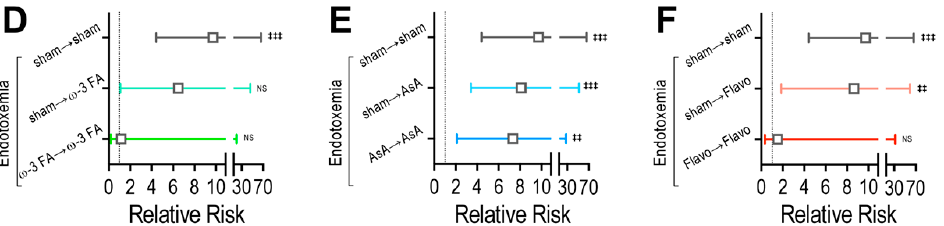
Figure 8. Survival and risk of death through dietary ω -3 FA, ascorbic acid, or polyphenolic antioxi- dant flavonoid supplementation in endotoxemic rats. Survival (Kaplan–Meier) curves comparing ω -3 FA ( A ), ascorbic acid ( B ), or polyphenolic antioxidant flavonoid ( C ) supplementation in saline- and endotoxemia-treated rats, through a therapeutic and a prophylactic protocol. *, § = 0.01 and 0.03 (log-rank (Mantel–Cox) test and Gehan–Breslow–Wilcoxon test, respectively) when comparing with endotoxemia-treated condition. ˆ, † = 0.004 and 0.007 (log-rank (Mantel–Cox) test and Gehan–Breslow–Wilcoxon test, respectively), when comparing with endotoxemia-treated condition. #, ¶ = 0.005 and 0.009 (log-rank (Mantel–Cox) test and Gehan–Breslow–Wilcoxon test, respectively), when comparing with saline-treated condition. &, ◦ = 0.004 and 0.007 (log-rank (Mantel–Cox) test and Gehan–Breslow–Wilcoxon test, respectively), when comparing with endotoxemia-treated condition. NS: non-significant ( N = 12). Contingency analyses performed to determine relative risk in endotoxemic rats supplemented with ω -3 FA ( D ), ascorbic acid ( E ), or polyphenolic antioxidant flavonoids ( F ) in endotoxemia-treated rats, through a therapeutic and a prophylactic protocol. ‡‡ p < 0.01; ‡‡‡ p < 0.001 (Fisher’s exact test) compared to saline-treated condition. Results are expressed as the mean ± 95% confidence interval (CI) NS: non-significant ( N = 12).